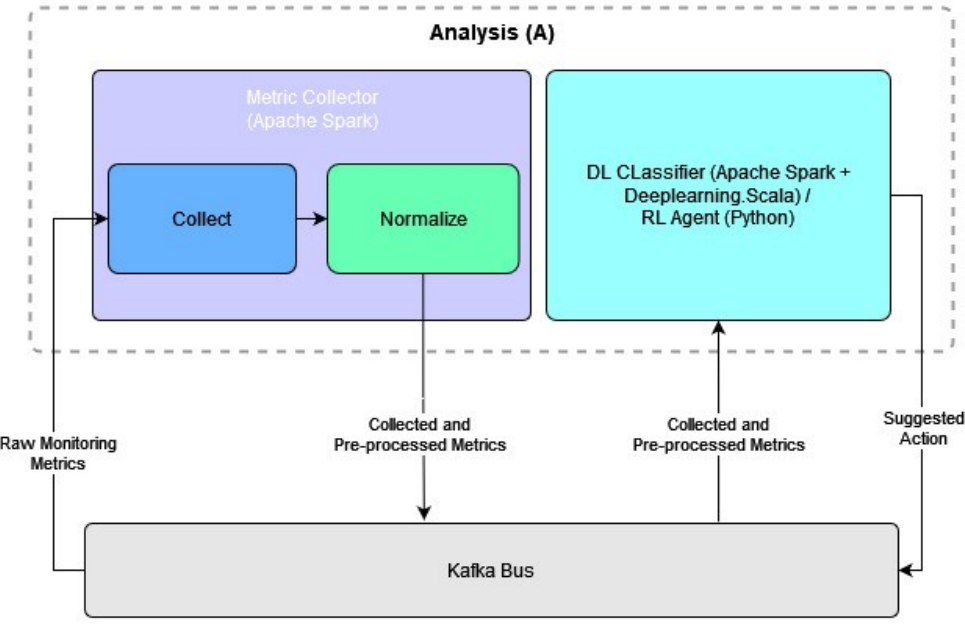
Figure 3. Components of MAPE’s AS